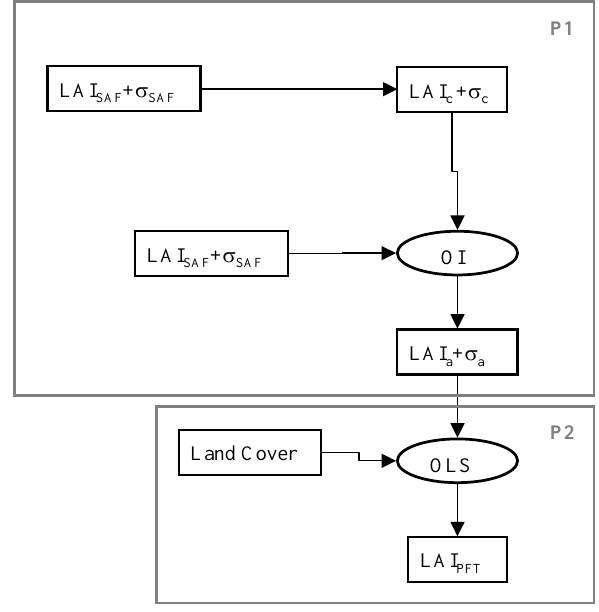
Fig. 1. Flowchart of the two-steps procedure to obtain LAI for each PFT in a given MSG/SEVIRI pixel. First, continuous and consistent LAI series are created at pixel level, LAI a , using a 4-yr climatology from LSA-SAF LAI, LAI SAF , actual LAI SAF , and an optimal in- terpolation (OI) method. Then, the pixel LAI is decomposed into LAI PFT for each PFT contributing to the pixel area, using a land cover map, LAI a and an ordinary least square method